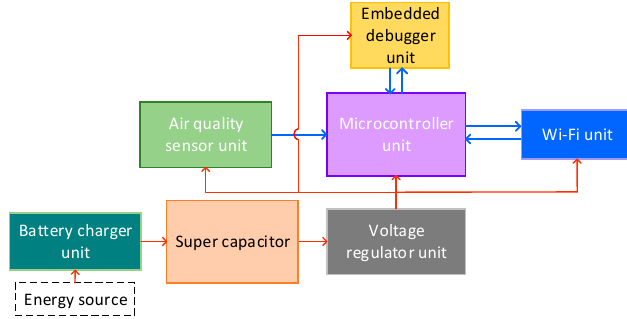
Figure 1. IAQ sensor node architecture.